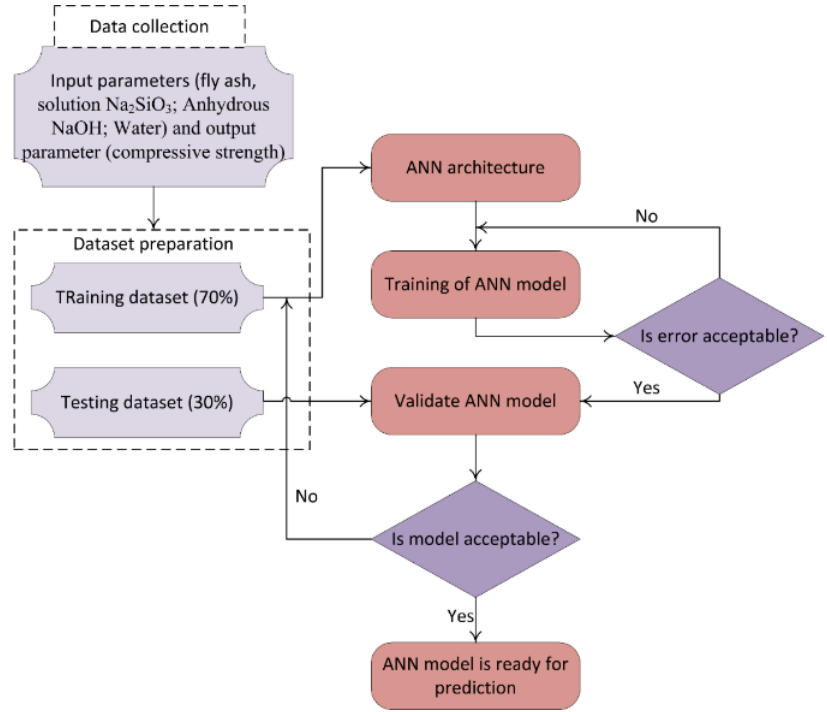
Figure 2. Methodology of development of an efficient artificial neural network (ANN) model [48]. Reprinted with permission from [48]. 2013, Mohd Idris Shah Ismail et al.